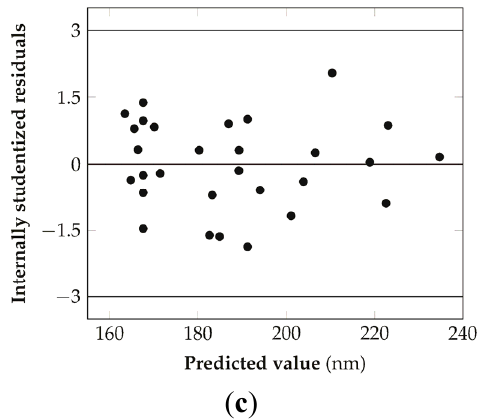
Figure 7. Diagnostic plots for the check of the consistency of the model developed: ( a ) Residuals versus run for the check of the presence of time-related variable lurking in the background, ( b ) Normal probability plot for the check of the normal distribution of the residuals, ( c ) Residual versus predicted values plot for the check of the assumption of constant variance of the